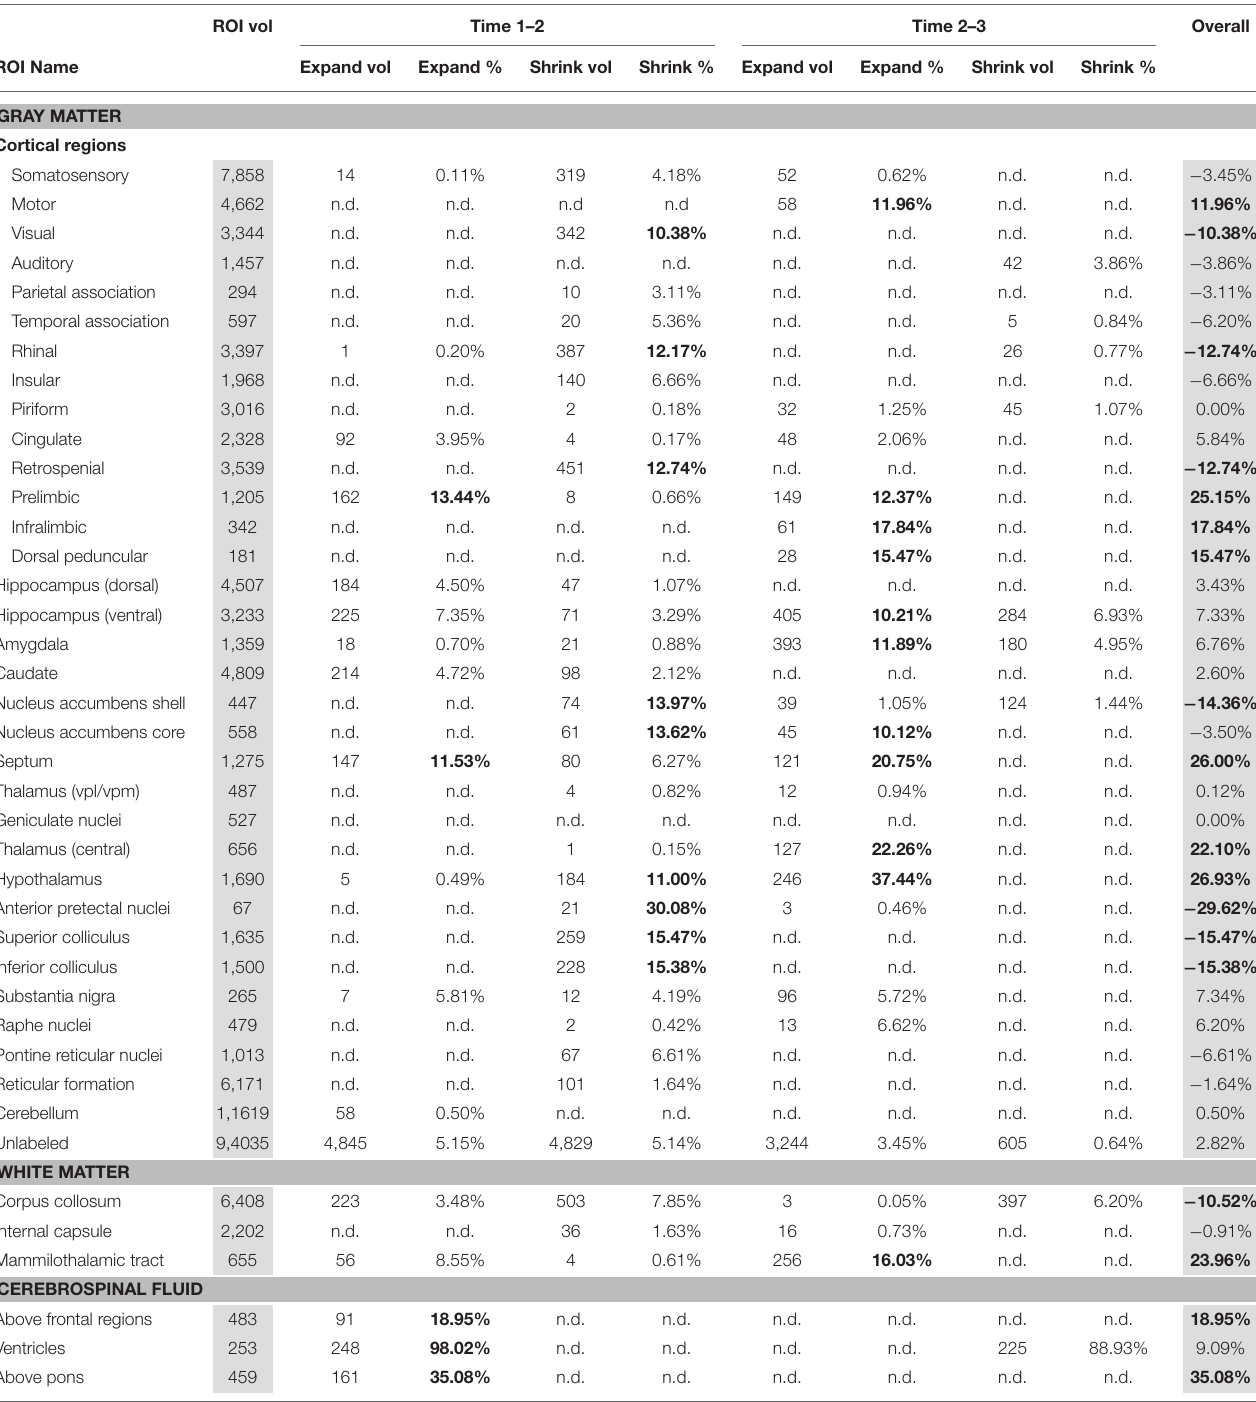
TABLE 2 | Within EtOH group analysis using PW